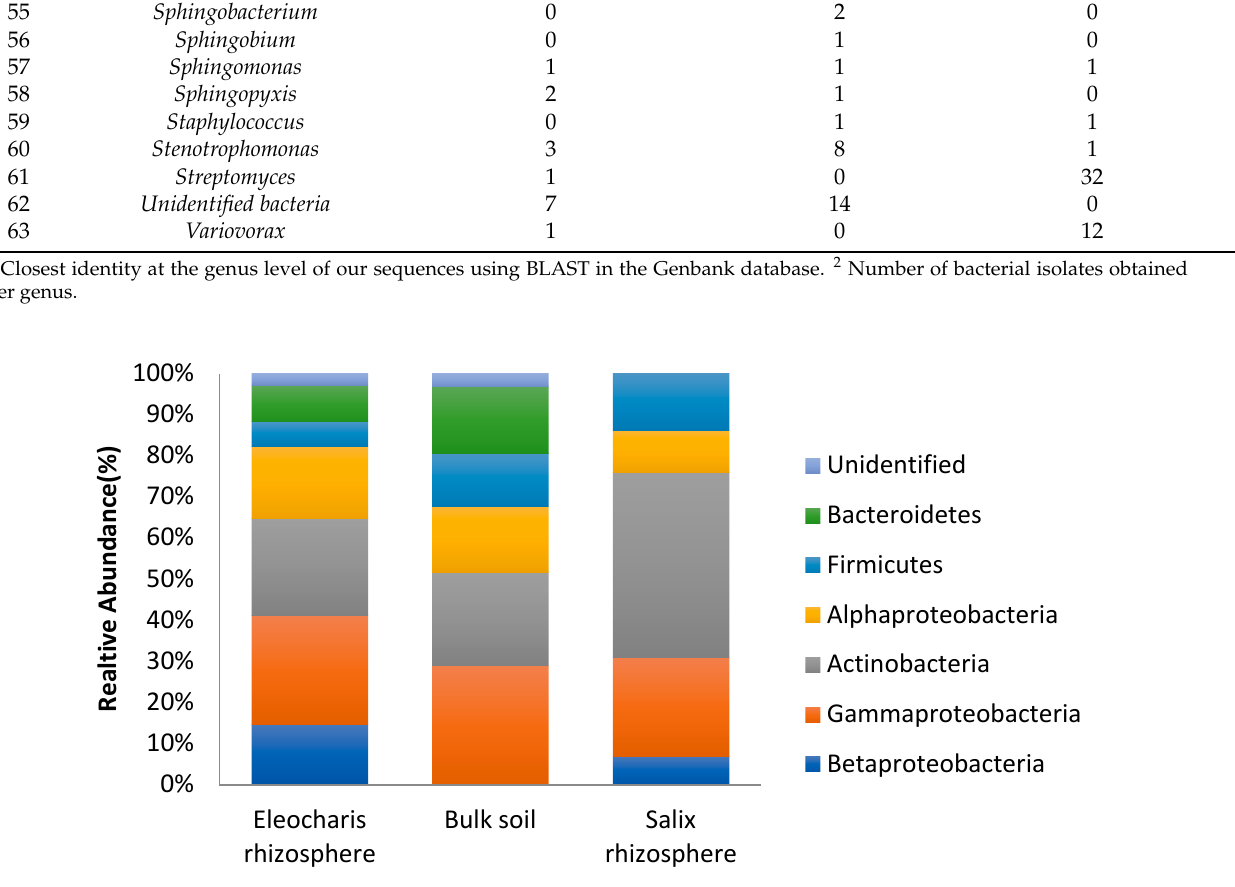
Figure 1. Taxonomic breakdown and relative abundance of bacterial isolates at the phylum level.